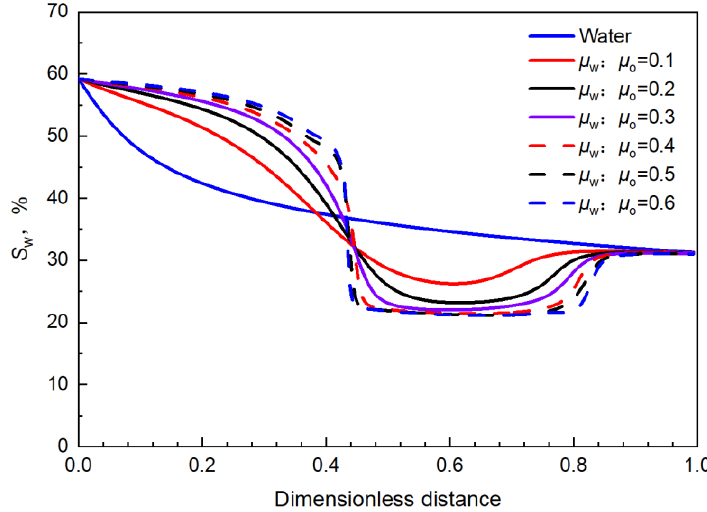
Figure 22. Comparison of water saturation distribution along the flow under different water – oil viscosity ratio conditions.